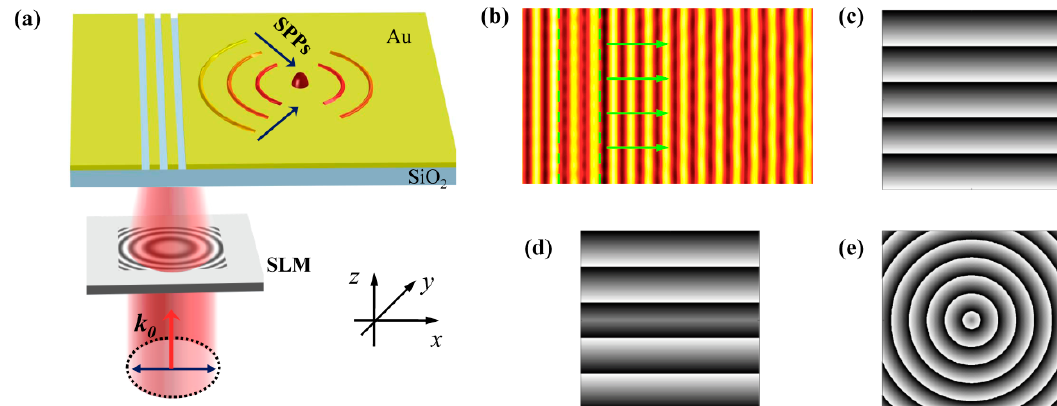
Figure 1. ( a ) Schematic diagram of the multifunctional plasmonic grating lens enabled by modulating the phase of light with SLM. ( b ) The SPPs wave propagates perpendicularly to the grating when no phase mask is loaded on the SLM. ( c – e ) The linear gradient phase, symmetrical phase, and spherical phase distributions addressed on the SLM, which can correspondingly excite the Cherenkov SPPs wake, nondiffracting SPPs Bessel beam, and focusing SPPs field.